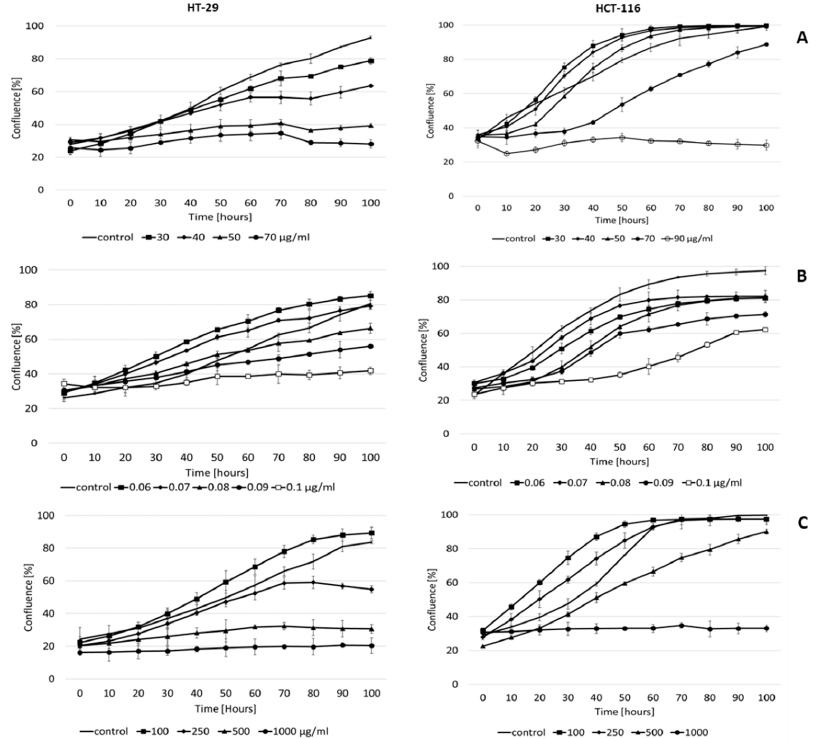
Figure 1. Effect of thymol-standard ( A ) and its derivatives DT1 ( B ) and DT2 ( C ) on the proliferation of cell lines HT-29 and HCT-116 during 100 h. Data are represented by means ± SD of three independent experiments.